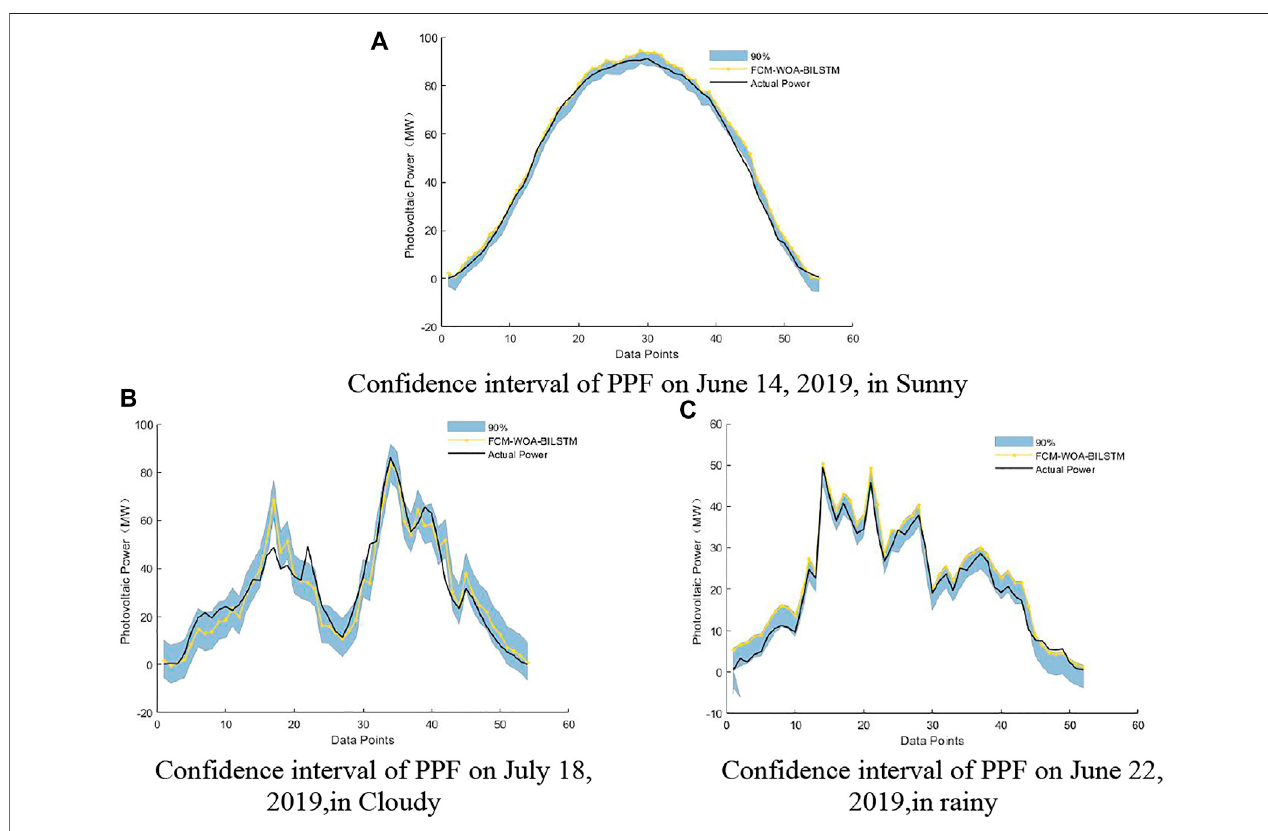
FIGURE 14 | 90% Con fi dence interval of PPF under different climatic conditions.